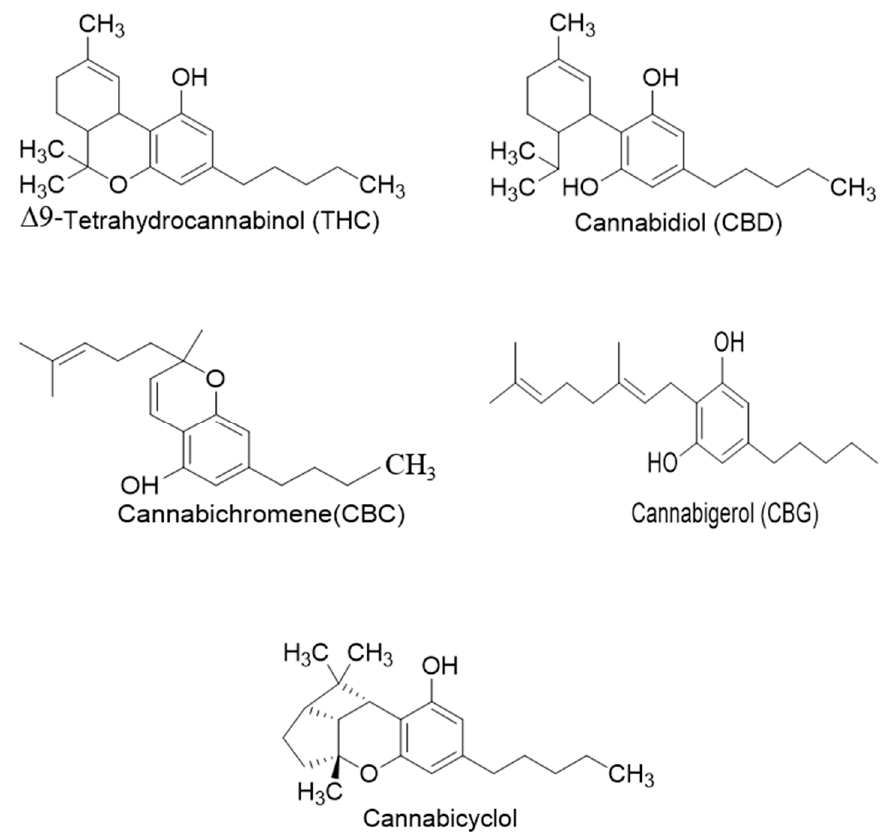
Figure 1. Structure of phytocannabinoids.